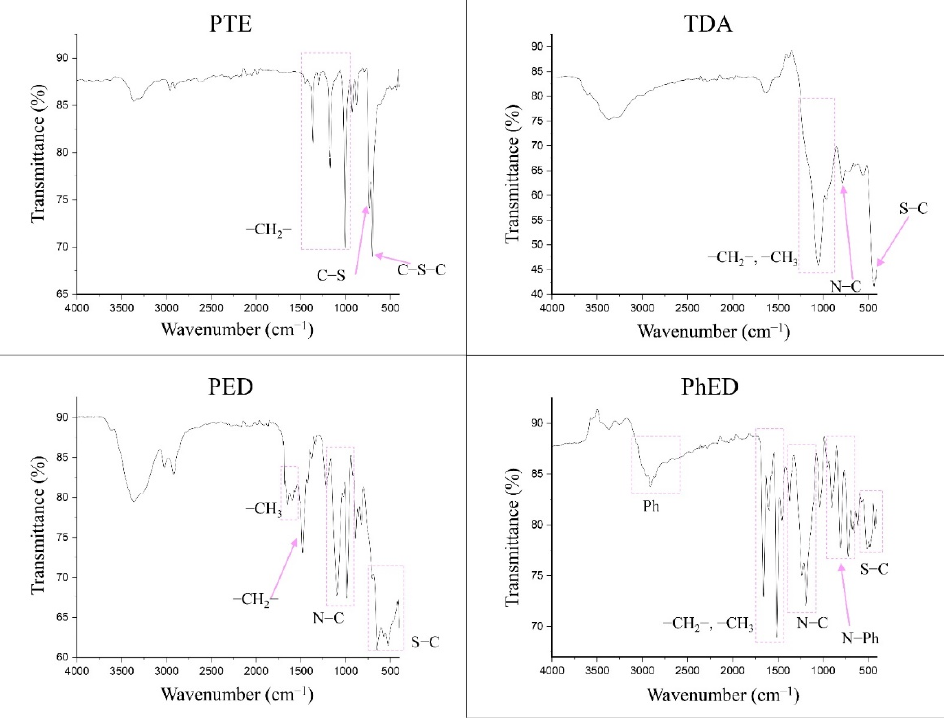
Figure 3. IR spectra of sorbents.